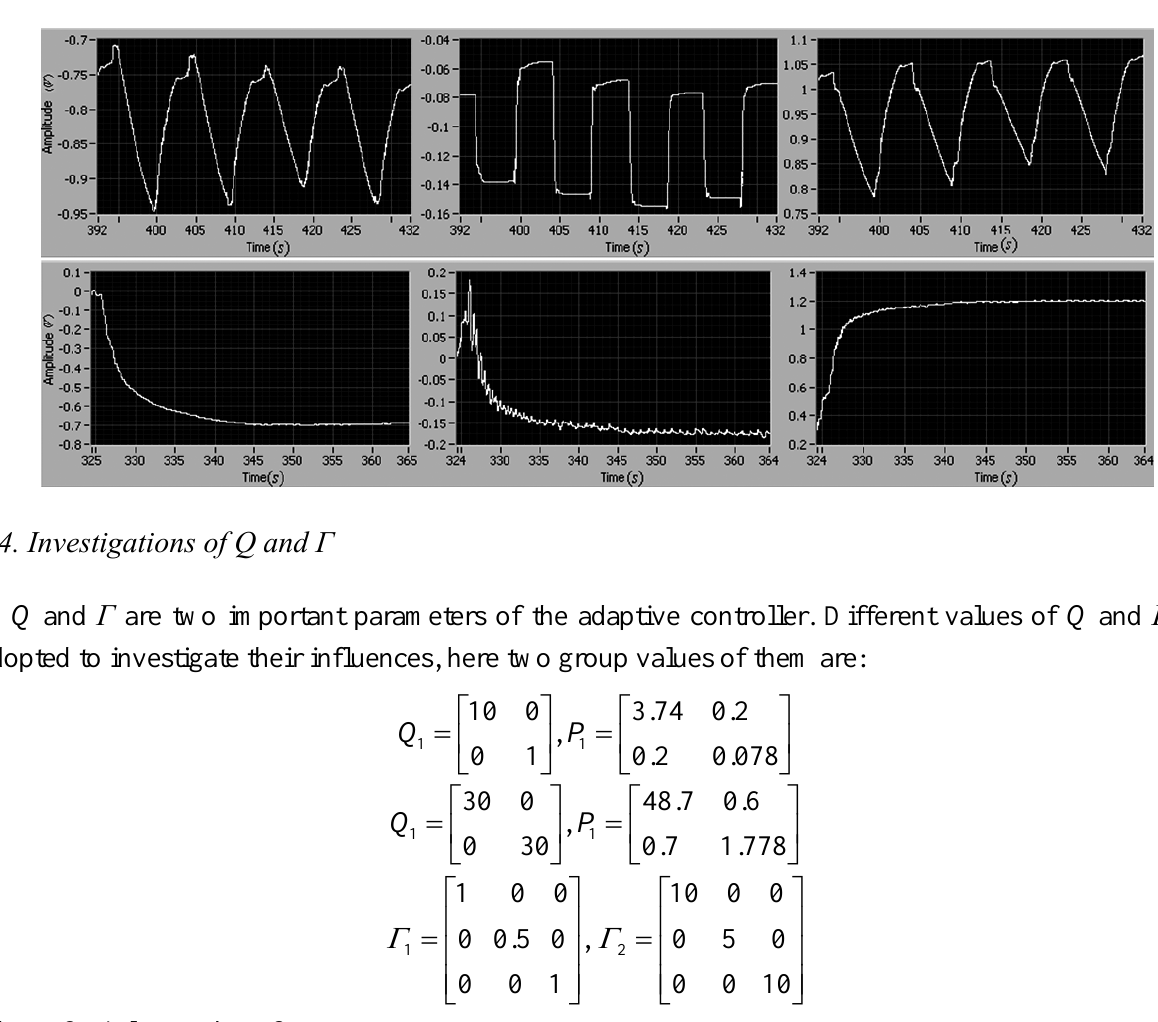
Figure 7.  responses under square wave tracking ( top ) and sinusoidal tracking ( bottom ),